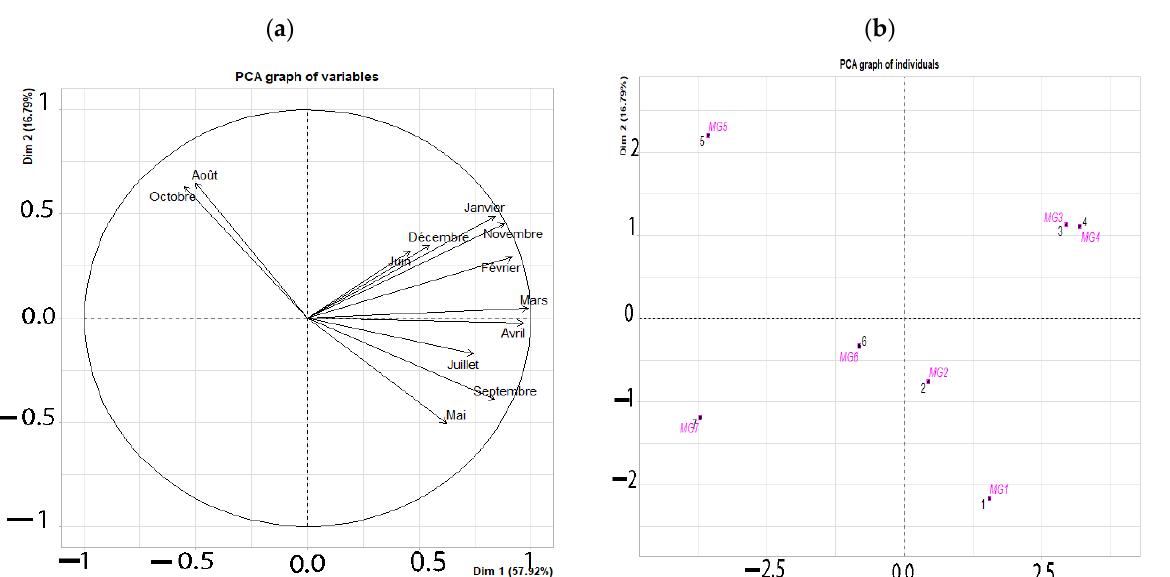
Figure 14. Principal component analysis of the climatology of the studied parameters according to the normalized grid maximums. Top figure ( a ) represents the graph of the variables. Bottom figure ( b ) represents the graph of the individuals.